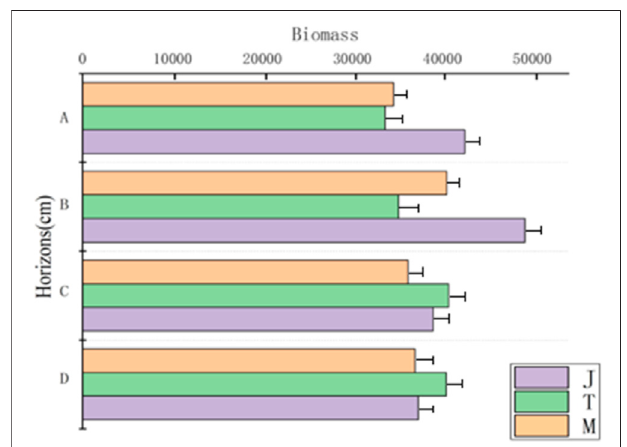
FIGURE 6 | Bacterial community composition at the phylum level of different frozen soil types (M1, M2, M3 and M4 represent the permafrost region of 0 – 10 cm, 10 – 30 cm, 30 – 50 cm and below 50 cm in Mohe, respectively; T1, T2, T3, and T4 represent the permafrost region of 0 – 10 cm, 10 – 30 cm, 30 – 50 cm and below 50 cm in Tahe, respectively; J1, J2, J3, and J4 represent the permafrost region of 0 – 10 cm, 10 – 30 cm, 30 – 50 cm, and below 50 cm in Jiagdaqi,